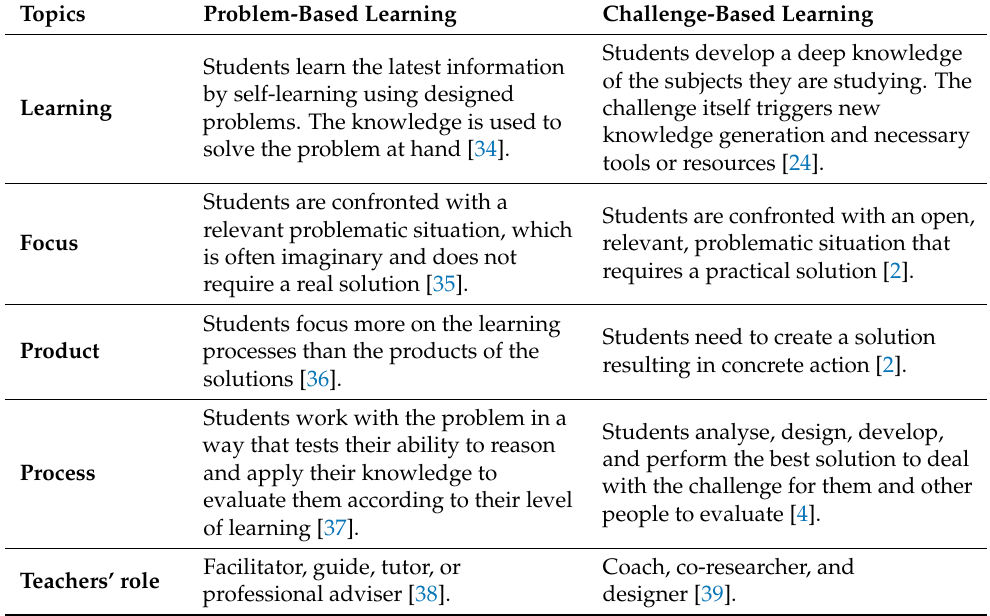
Table 1. Learning methods of problem-based learning and challenge-based learning.